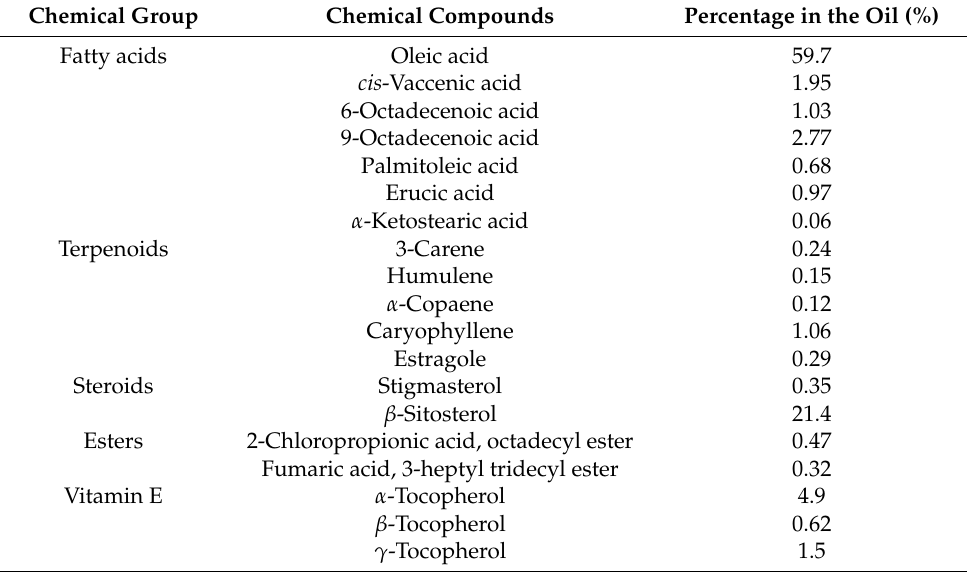
Table 2. Chemical composition of the fixed oil from M. oleifera seeds